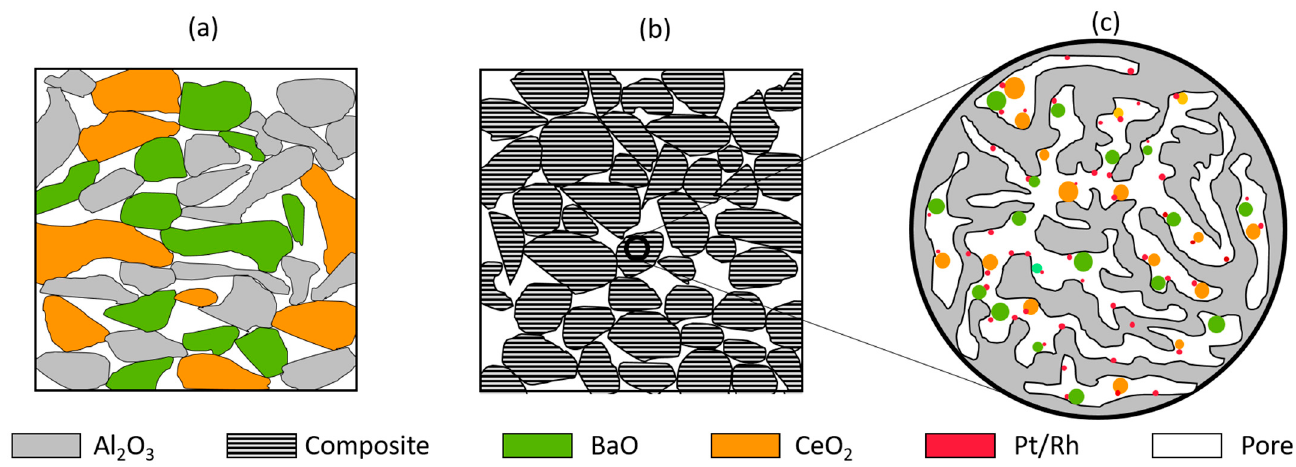
Figure 6. Textures of ( a ) the reference LNT, ( b ) the infiltration composite (Pt/Rh/Ba 10 Ce 25 Al 2 O 3 ) and ( c ) the distribution of the functional materials within the pore system of the alumina support (zoom).